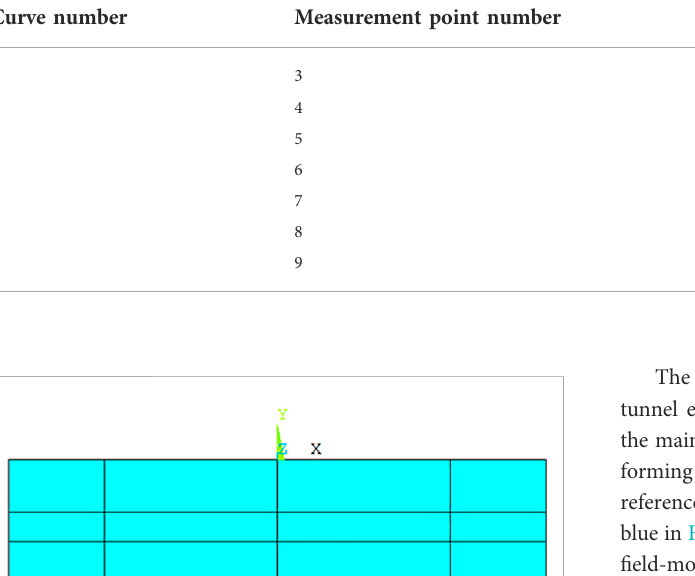
TABLE 1 Average increment of surface subsidence.